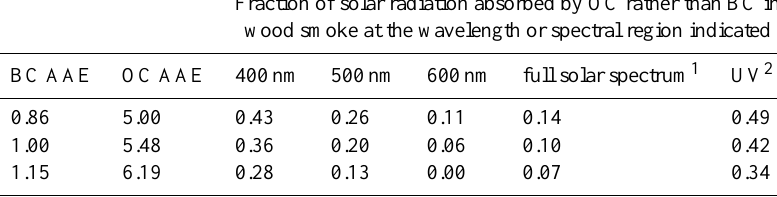
Table 1. Derived values of OC AAE and OC contribution to wood smoke absorption of solar radiation as they depend on the chosen value of BC AAE. Fraction of solar radiation absorbed by OC rather than BC in wood smoke at the wavelength or spectral region indicated